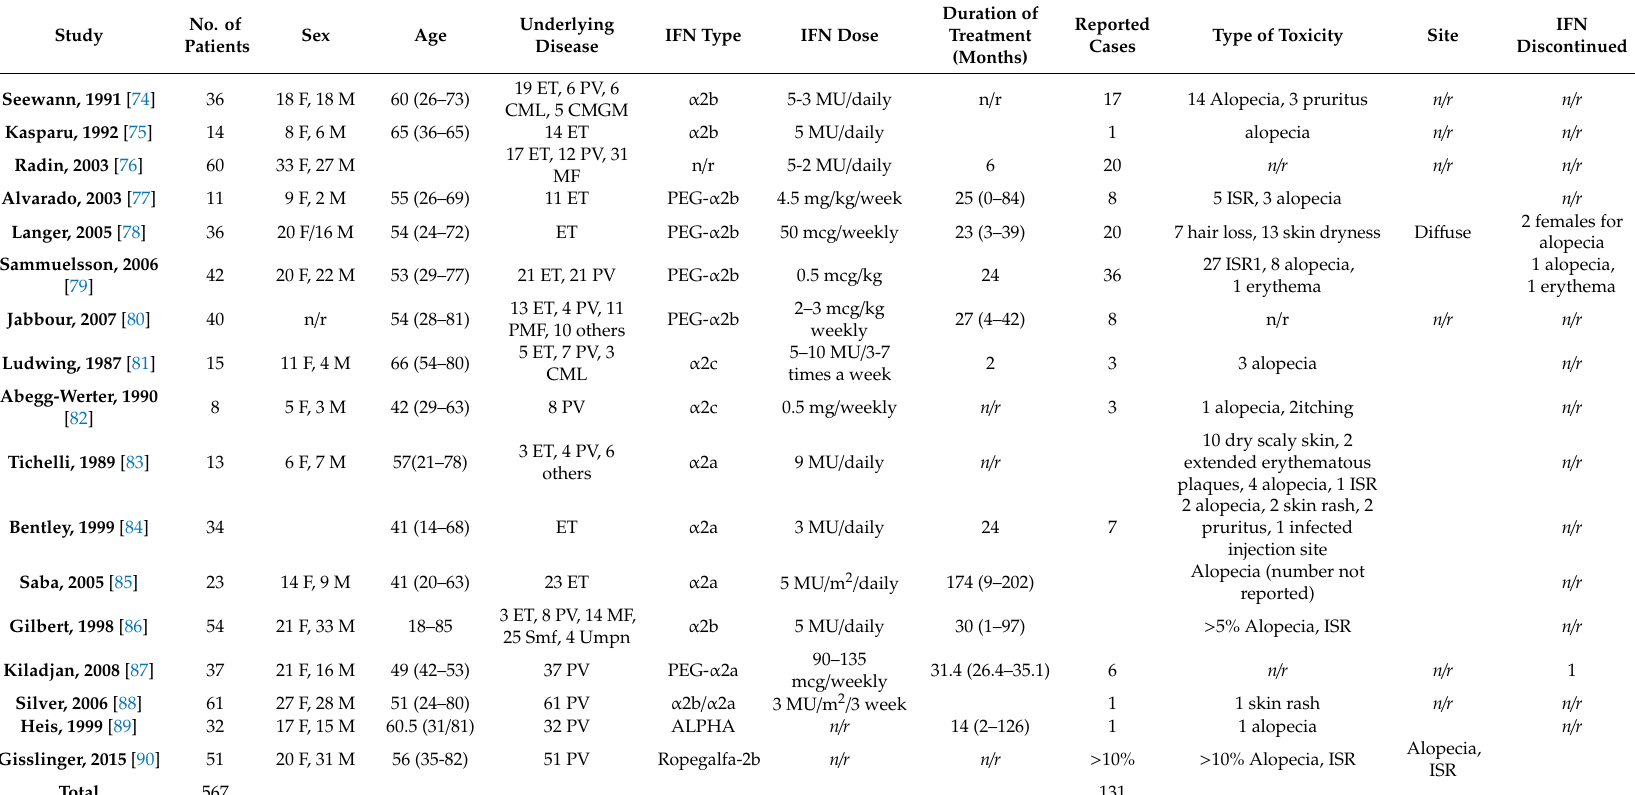
Table 3. Reported cases of interferon (IFN)-induced cutaneous